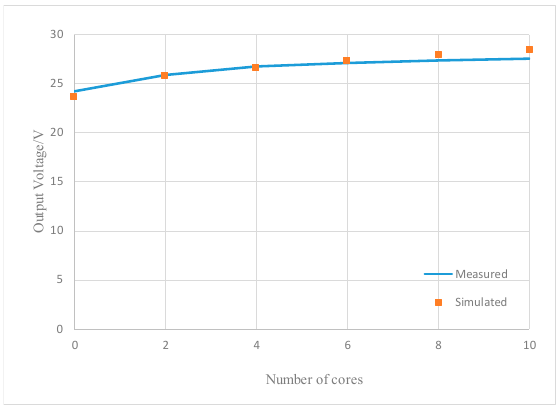
Figure 18. Comparison between simulated and measured output voltages with the increasing ferrite core bars.